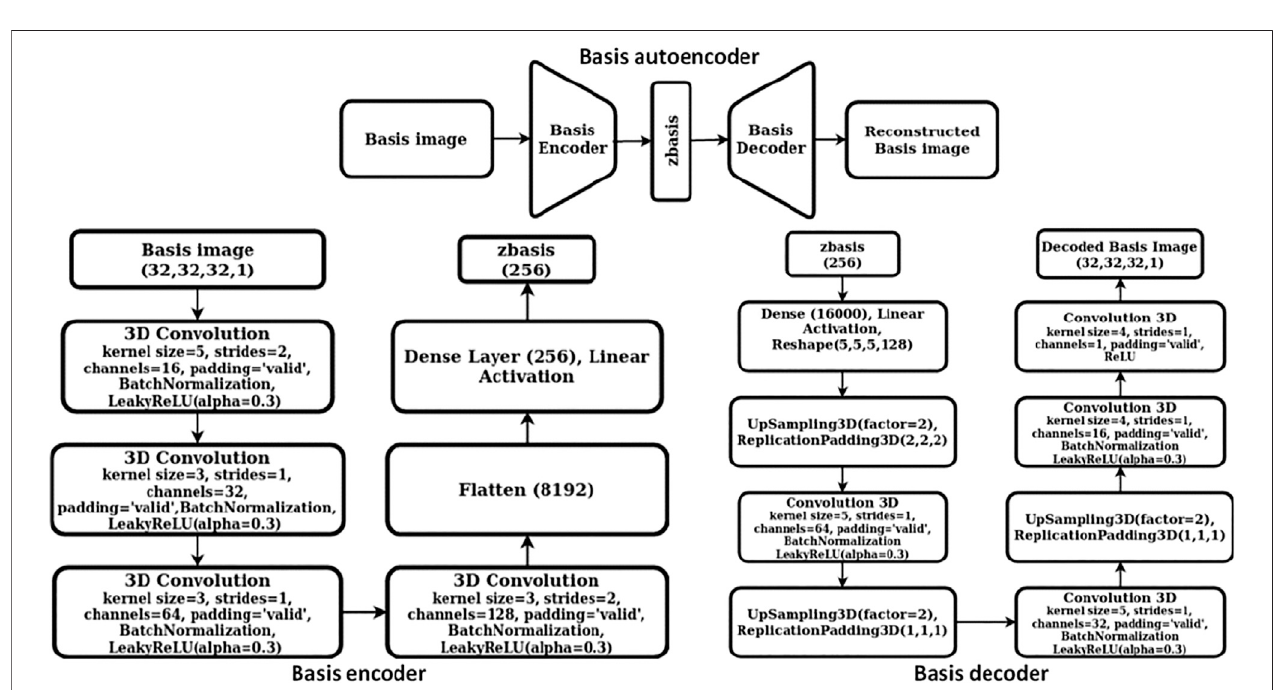
FIGURE 3 | Architecture of the basis